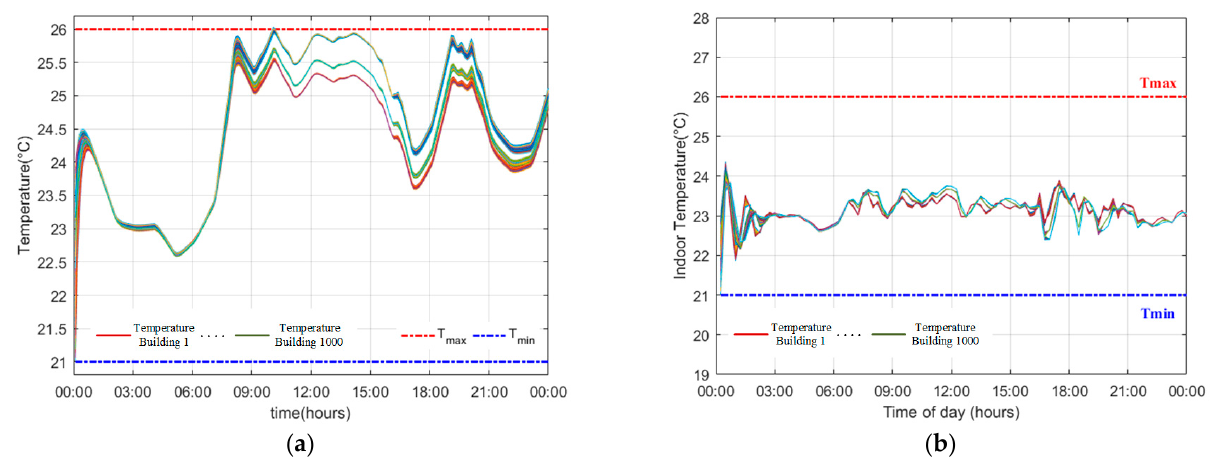
Figure 12. Indoor temperatures of the buildings hosted in the distribution network. ( a ) Optimization. ( b ) Typical case.